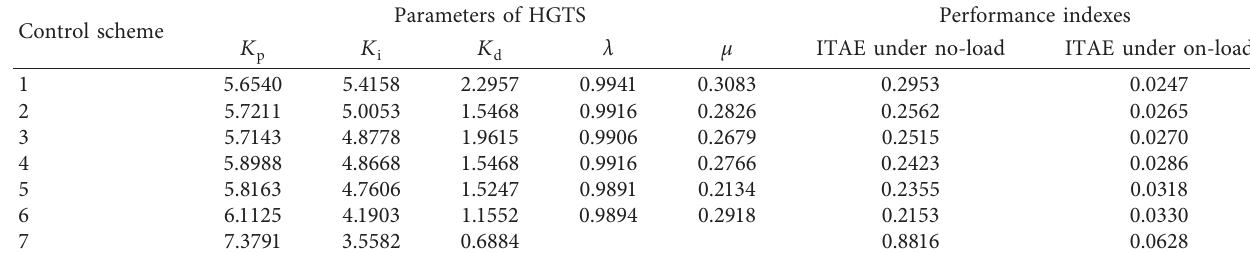
Figure 7: Pareto fronts optimized by HMOHHO for multiobjective control problems of HTGS based on PID and FOPID controllers. Table 4: Control schemes selected from the Pareto-optimal solution